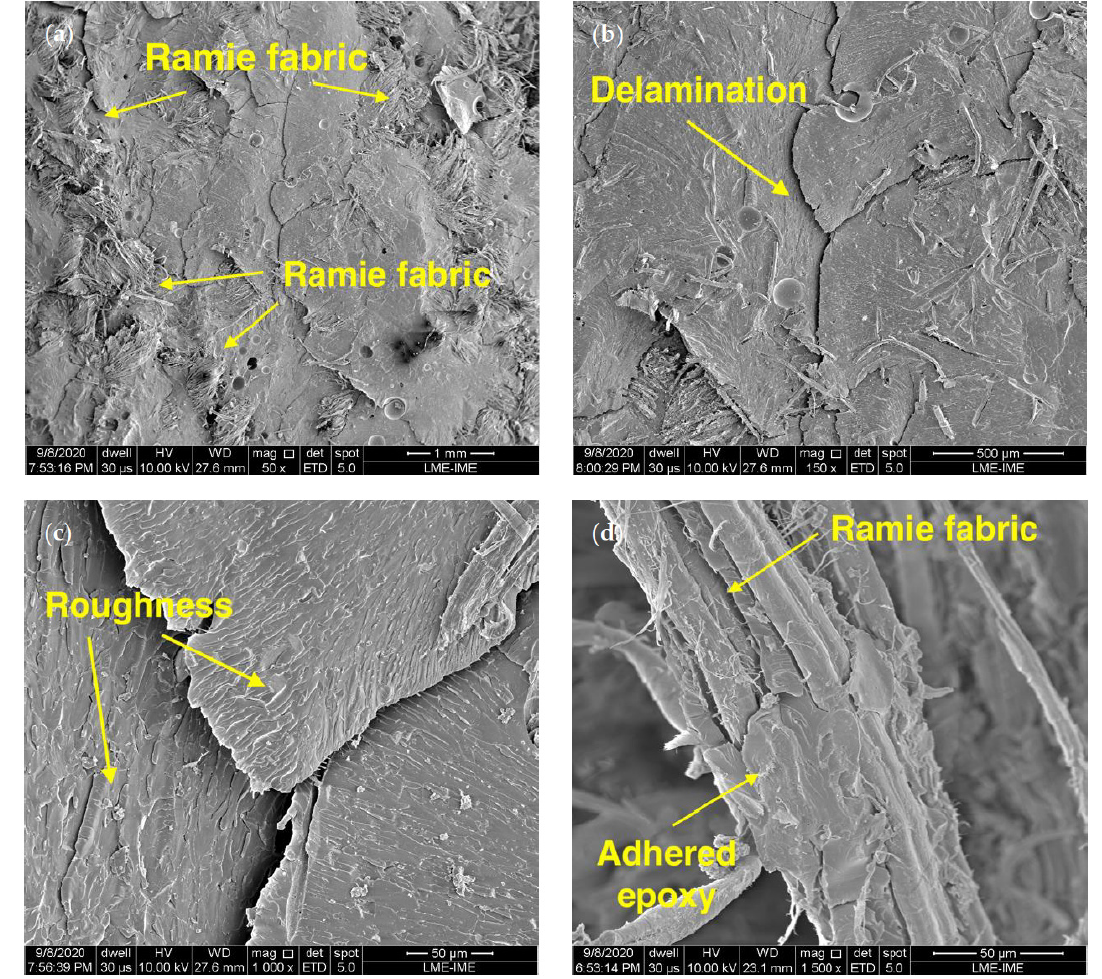
Figure 4. SEM of the fracture surface of the ballistic test with an increase of ( a ) 50×, ( b ) 150×, ( c ) 1000× and ( d ) 1500×.